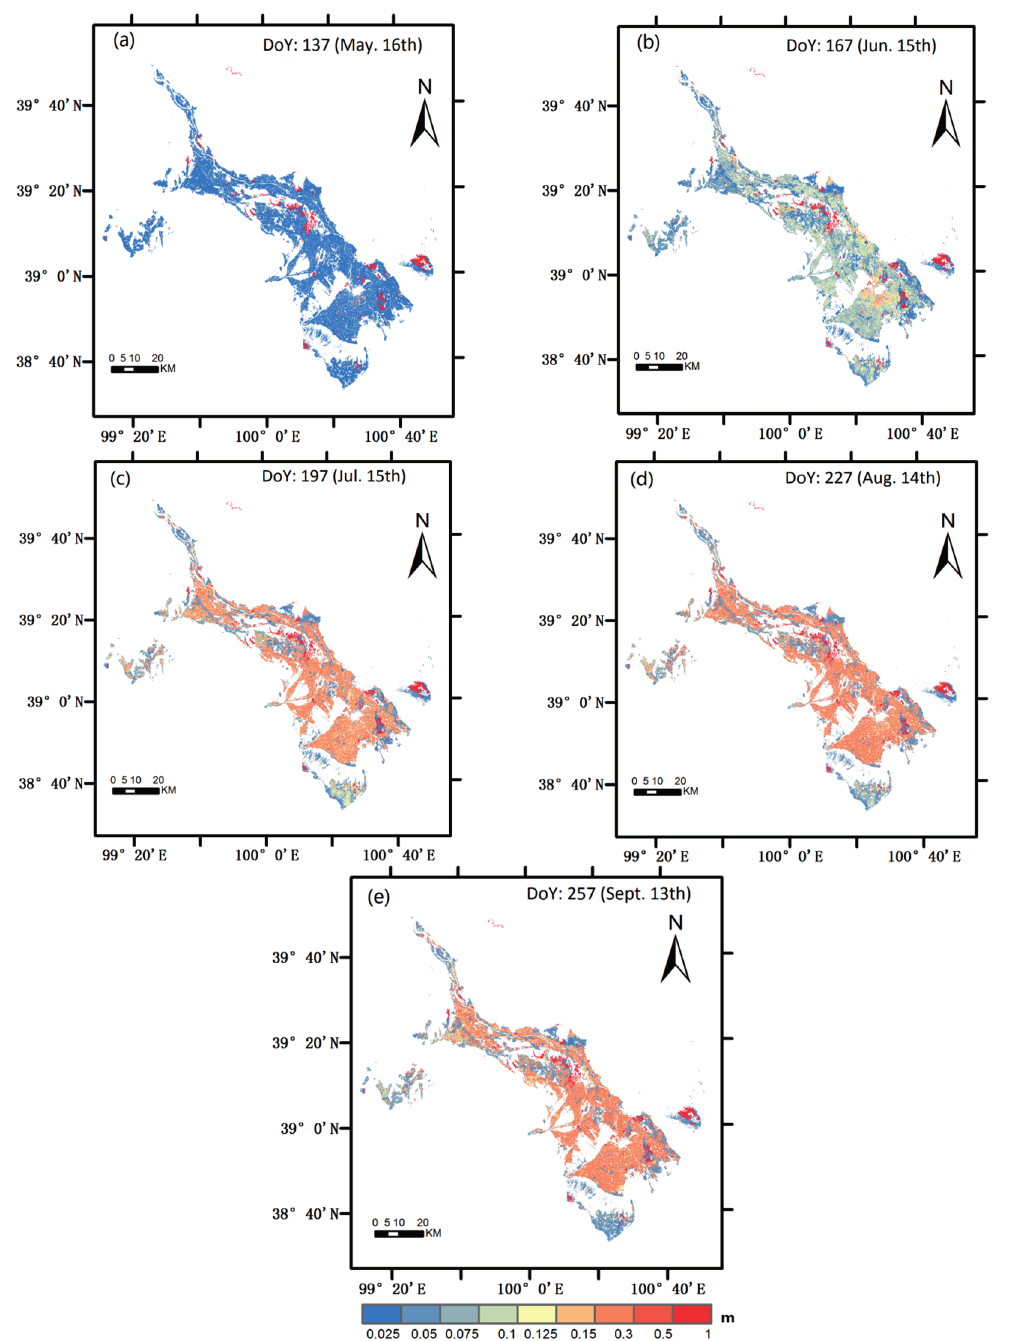
Figure 6. Aerodynamic roughness length in the period of May to September 2012 on days of year: ( a ) 137, ( b ) 167, ( c ) 197, ( d ) 227, and ( e )